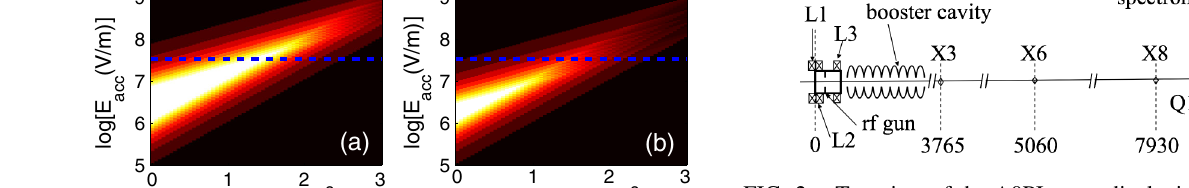
FIG. 2. Top view of the A0PI setup displaying elements perti- nent to the present simulations and experiments. The ‘‘L’’ refers to solenoidal lenses, ‘‘X’’ to diagnostic stations (beam viewers and/or multislit masks location), and ‘‘Q’’ to quadrupole mag- nets. The distances are in mm and referenced to the photo- cathode surface.